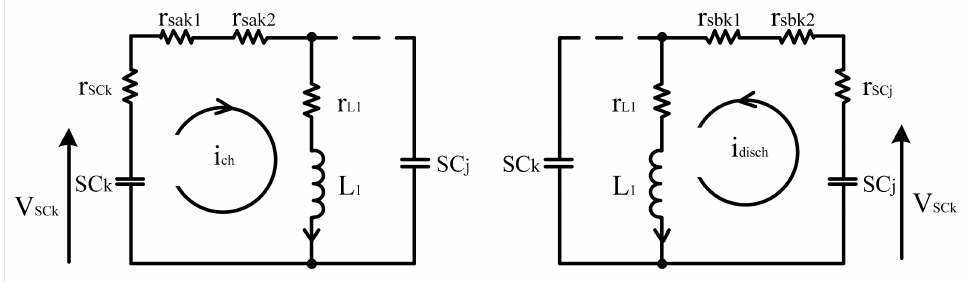
Figure 7. Model of the buck-boost mode circuit under charging and